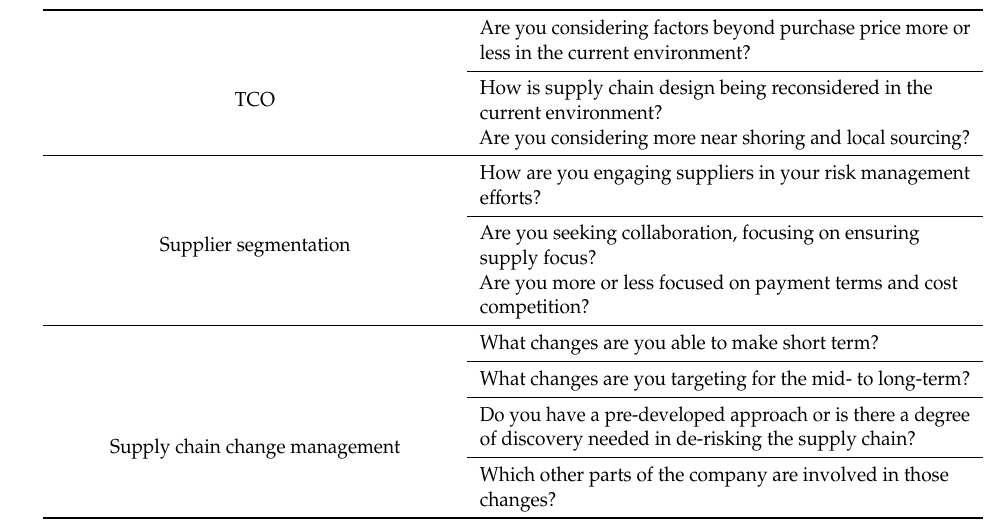
Table 2. Example interview